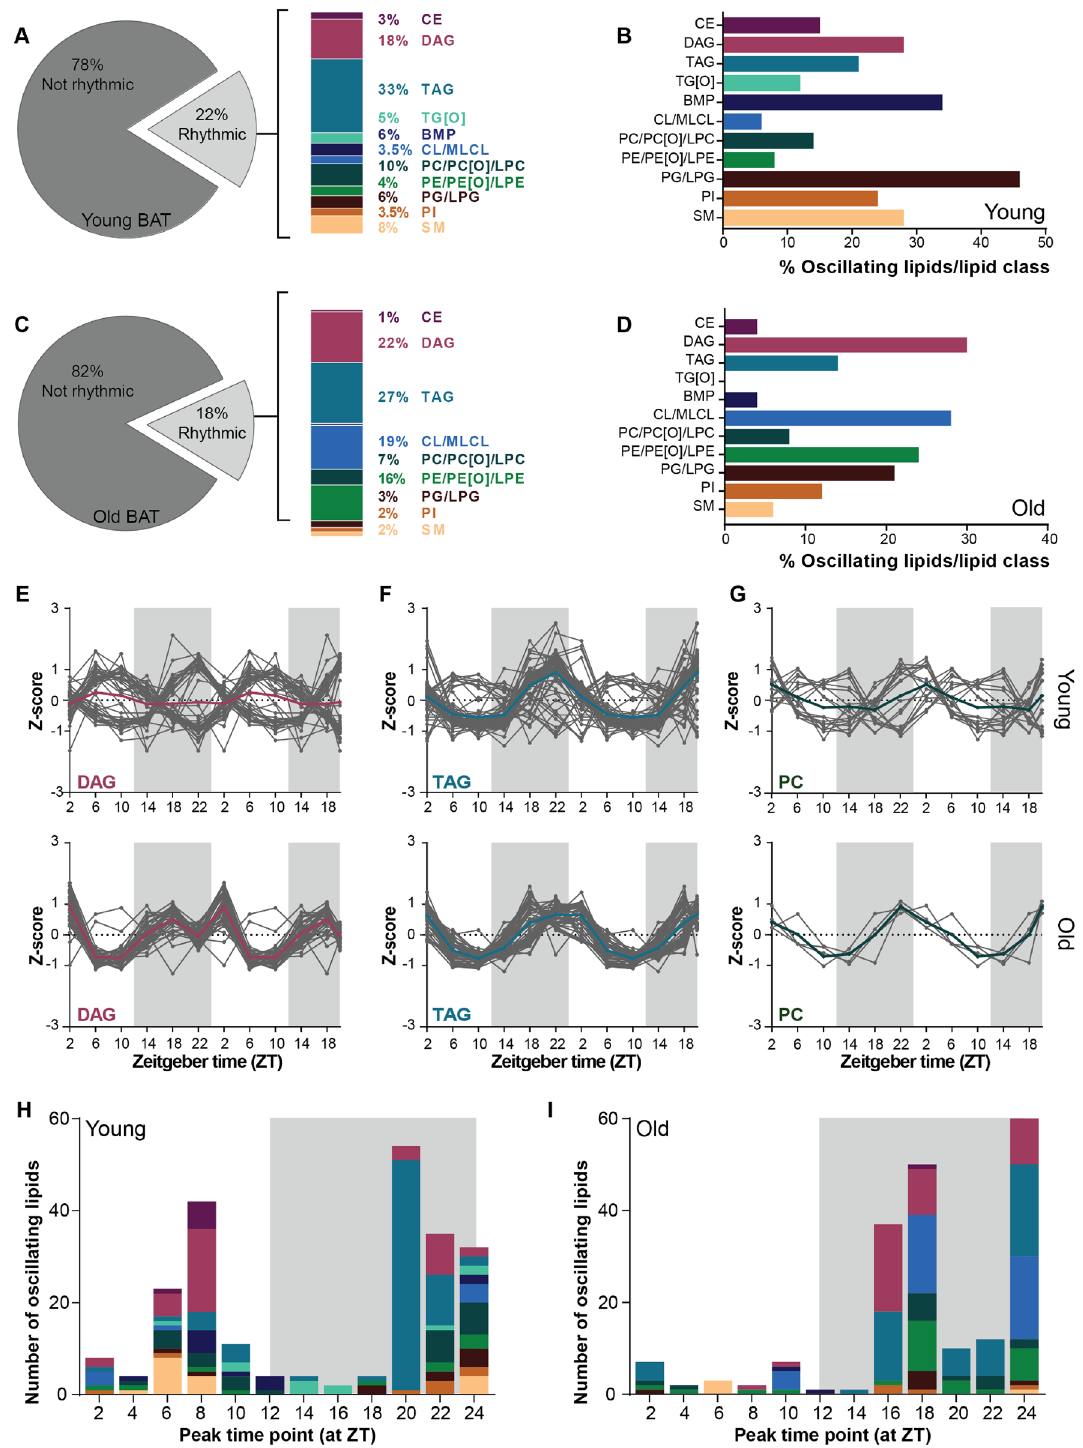
Figure 5. Rhythmic lipid profiles is influenced by acyl chain length in young BAT. ( A ) Percentage of rhythmic lipids in young and ( C ) aged mice as considered by JTK_CYCLE analysis. The rhythmic lipids contained lipids of different lipid classes. Depiction of the rhythmic/lipid class percentage of young ( B ) and ( D ) aged mice (n = 4 per time point). Double plotted rhythmic profiles of ( E ) DAGs, ( F ) TAGs and ( G ) PCs in young mice compared to aged mice. The gray lines represent the individual lipid species and the bold colored lines the group average. The peak time point of individual lipids species depicted with the color to their corresponding lipid class of young ( H ) and ( I ) aged mice. Graphs were created in Graphpad Prism (v8.3.0; https ://www.graph pad.com/scien tific -softw are/prism /). Figure layout was prepared in Adobe Illustrator CS6 (v16.0.3; https ://www.adobe .com/